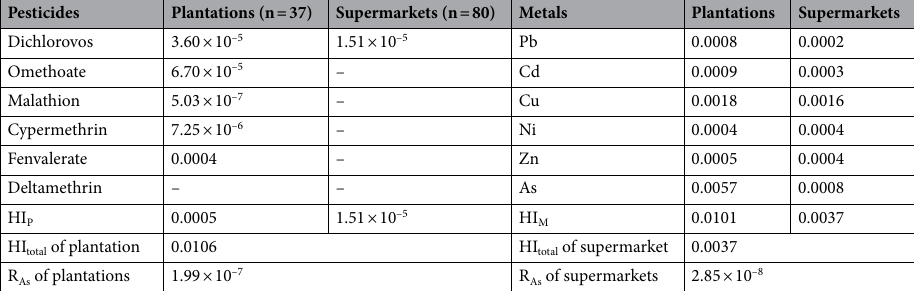
Table 3. Non-carcinogenic risk (hazard quotient (HQ) and hazard index (HI)) of pesticides and metals and carcinogenic risk (R) of As in Goji berries. – means no available value. HI P means HI of pesticides and HI M means HI of metals.